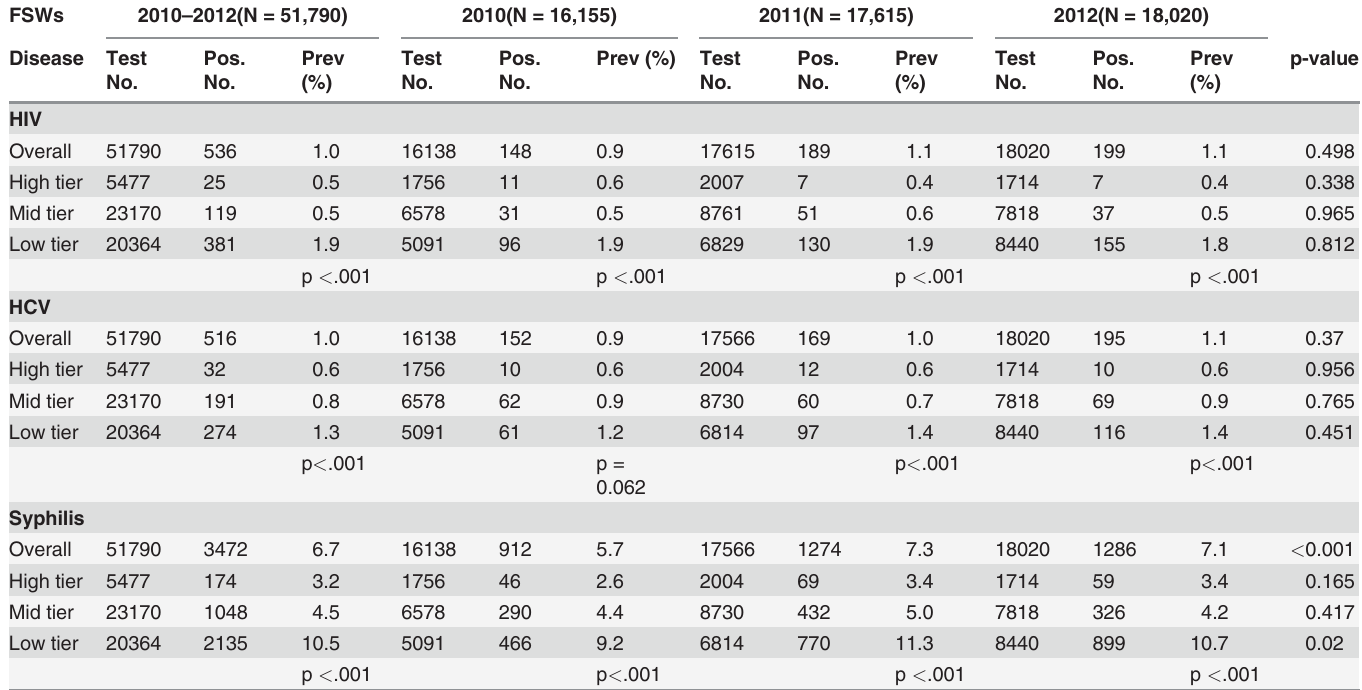
Table 2. HIV, hepatitis C, and syphilis testing results for female sex workers (FSWs) from Guangxi Province, China; China National CDC HIV/ AIDS Surveillance Data, 2010 – 2012,N =